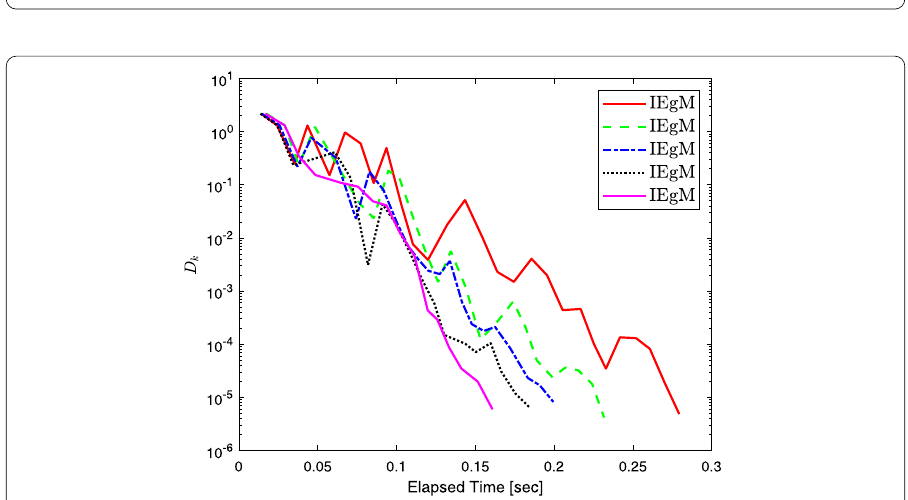
starting points for these numerical studies are u –1 = v –1 = u 0 = (1,1,...,1), M = 5, and er- ror term D k = (cid:10) u k +1 – u k (cid:10) . Figures 3 and 4 show a number of results for the error term D k = (cid:10) u k +1 – u k (cid:10) ≤ 10 –5 . Information concerning the control parameters shall be consid-